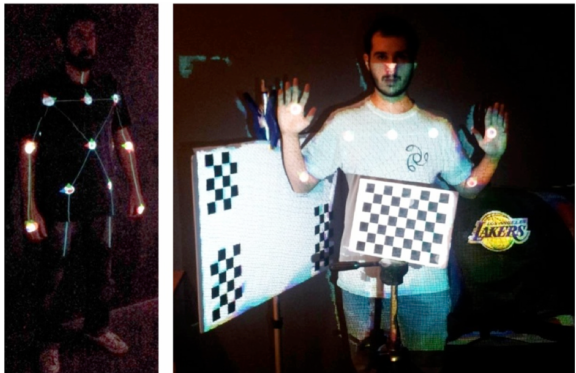
Figure 17 - Left: Mapping Skeleton. Right: Mapping Depth with the RGB camera